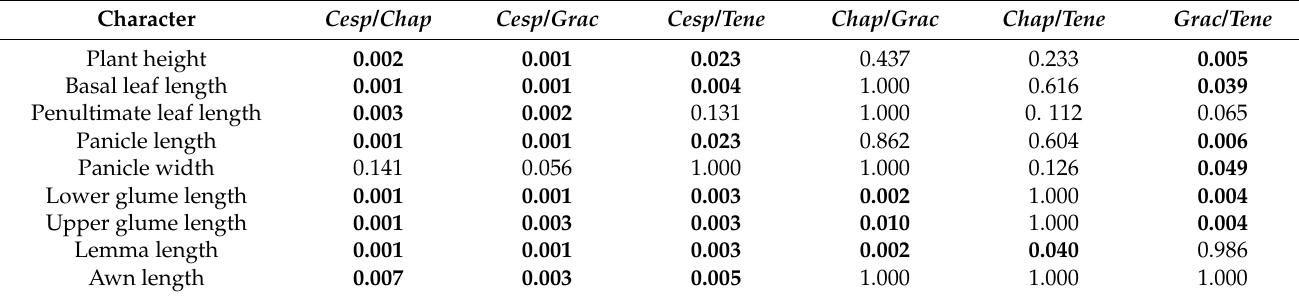
Figure 5. Boxplots showing variation in morphological traits in New Zealand Deschampsia cespitosa and three endemic taxa. Levels not connected by the same letter are significantly different according to the Mann–Whitney-U-tests ( p < 0.05). Taxa codes: Ces = D. cespitosa , Ten = D. tenella , Gra = D. gracillima , Cha = D. chapmanii . p values of Mann–Whitney-U-tests for pairwise comparisons are shown in Table 1. Additional boxplots are given in Figure S8. Table 1. Bonferroni-corrected p values of Mann–Whitney-U-tests for pairwise comparisons between New Zealand Des- champsia taxa. Significant values <0.05 highlighted in bold.